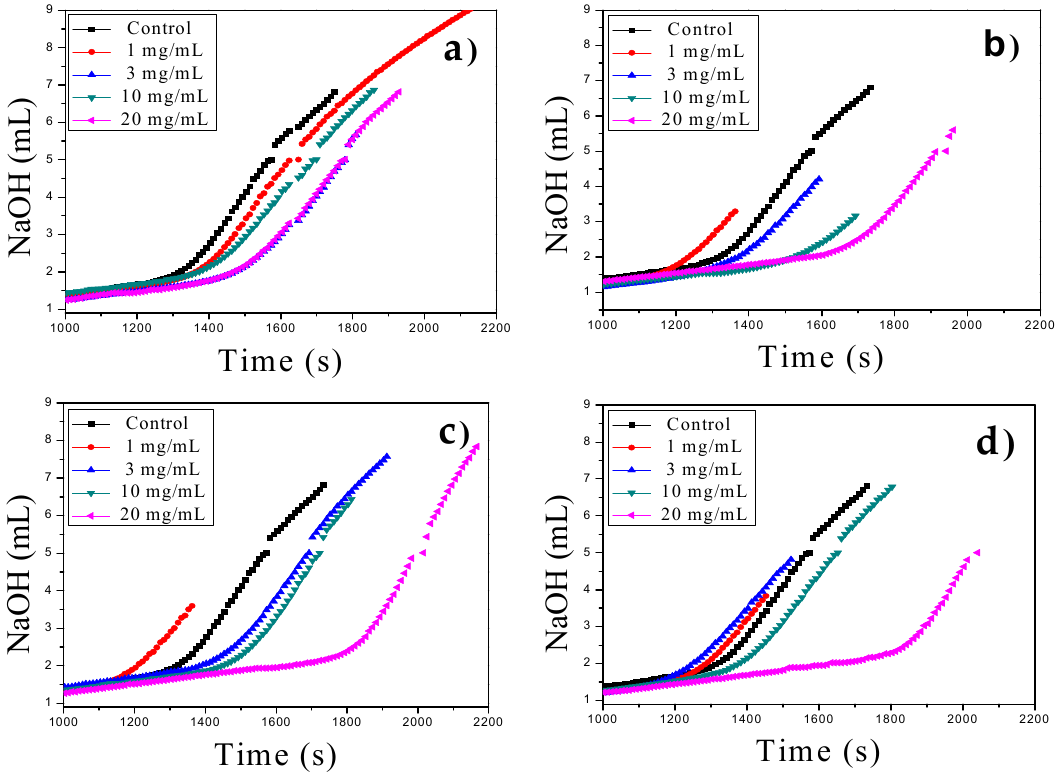
Figure 3. Prenucleation cluster (PNC) assays of CaCO 3 using MWCNTs in the range of 1–20 mg/mL at constant pH of 9.0 at 20 °C: ( a ) MWCNT, ( b ) MWCNT-Ox, ( c ) MWCNT-IA, and ( d ) MWCNT-MMI.